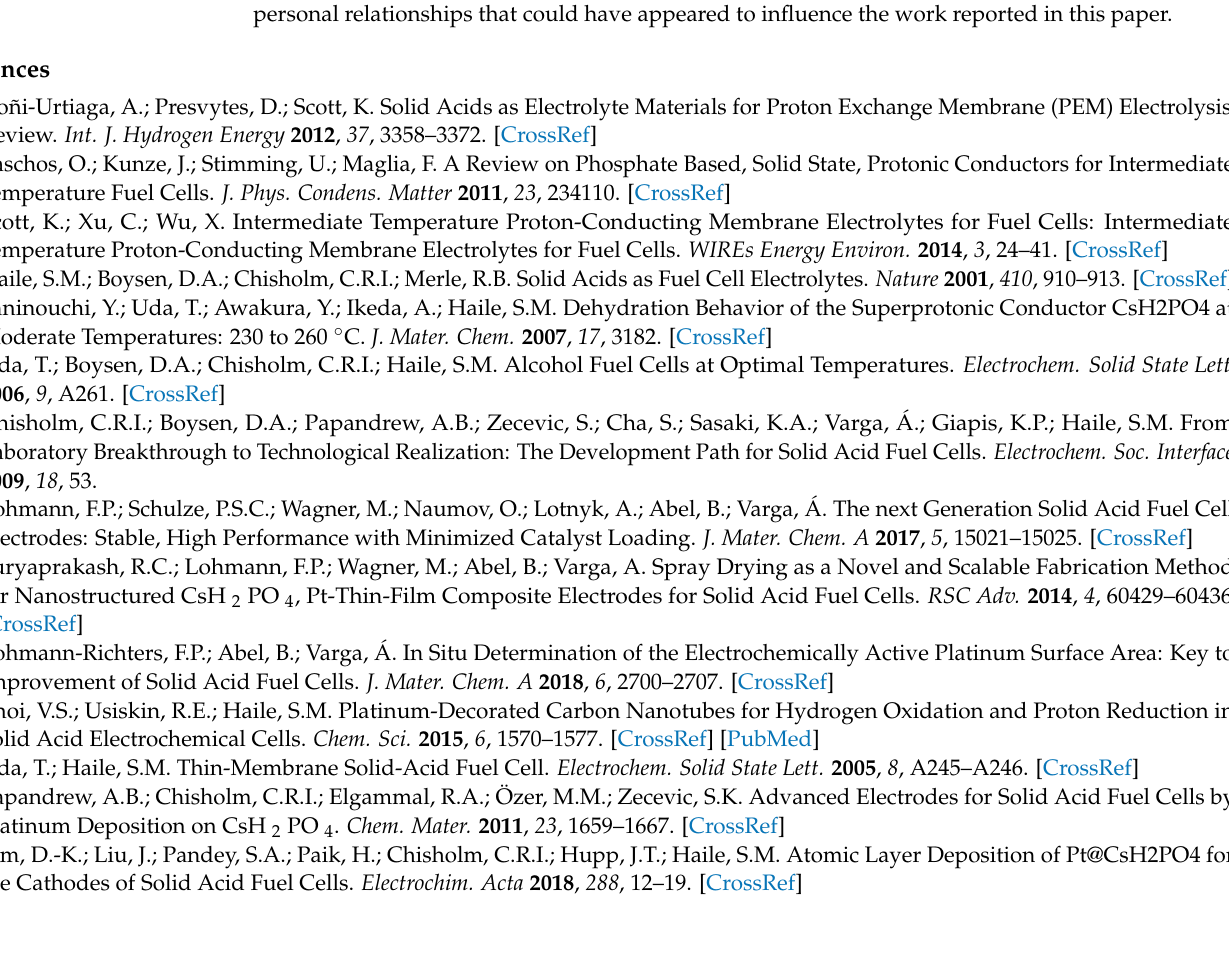
Re(Z) and green- residuals of Im(Z)) from the potential electrochemical impedance measurement pre and post fuel cell operation (with an offset of 2%) according to the Kramers-Kronig relation. The dotted, grey lines present the validity region of ± 1%. Figure S10b: Impedance data residuals (blue- residuals of Re(Z) and green- residuals of Im(Z)) from the impedance measurement under anodic conditions for two 0.5 and 5 Pa MEAs according to the Kramers-Kronig relation. For clarification, each measurement has an offset of 2%. The dotted, grey lines present the validity region of ± 1%. Figure S11: Nyquist representation of the open-structured GDE impedance of the varied layer thicknesses measured under anodic fuel cell conditions (513 K, 60 sccm H 2 and 0.3 atm H 2